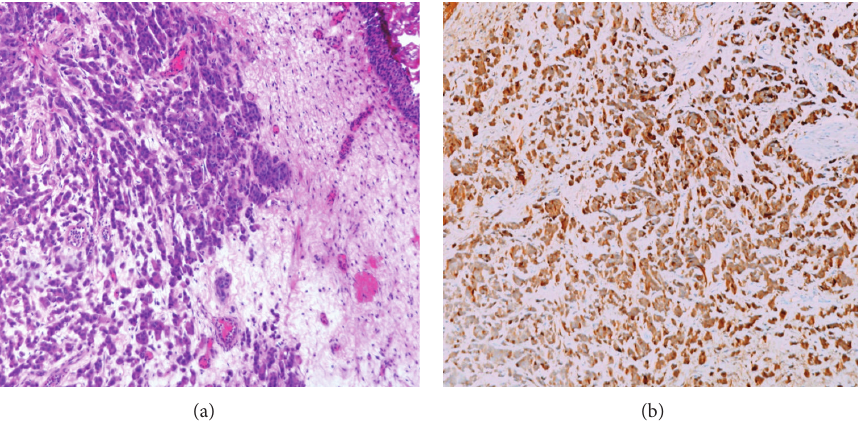
Figure 2: Metastatic lobular carcinoma. Bland-appearing tumor cells are arranged in strands with occasional single-signet ring-like cells, invading the stroma (hematoxylin & eosin, Nikon E1000, original magnification ×100 ) (a) and metastatic cells stain positively for apocrine marker GCDFP-15 (Nikon E1000, original magnification ×100 )